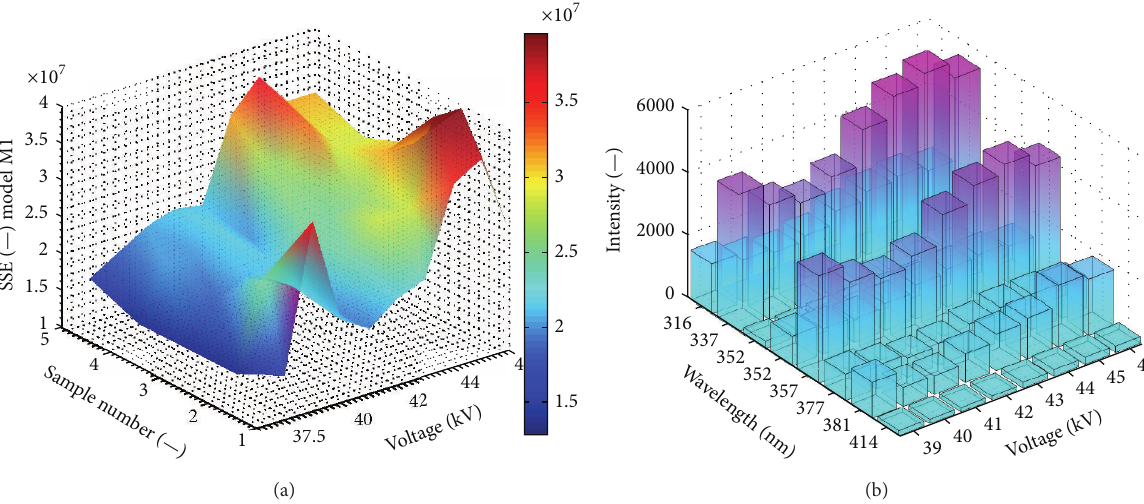
Figure 23: (a) Comparison of SSE coefficient values obtained in model M1 for all the recorded signals. (b) Dependence of the intensity of individual wavelengths as a function of PD generation voltage.